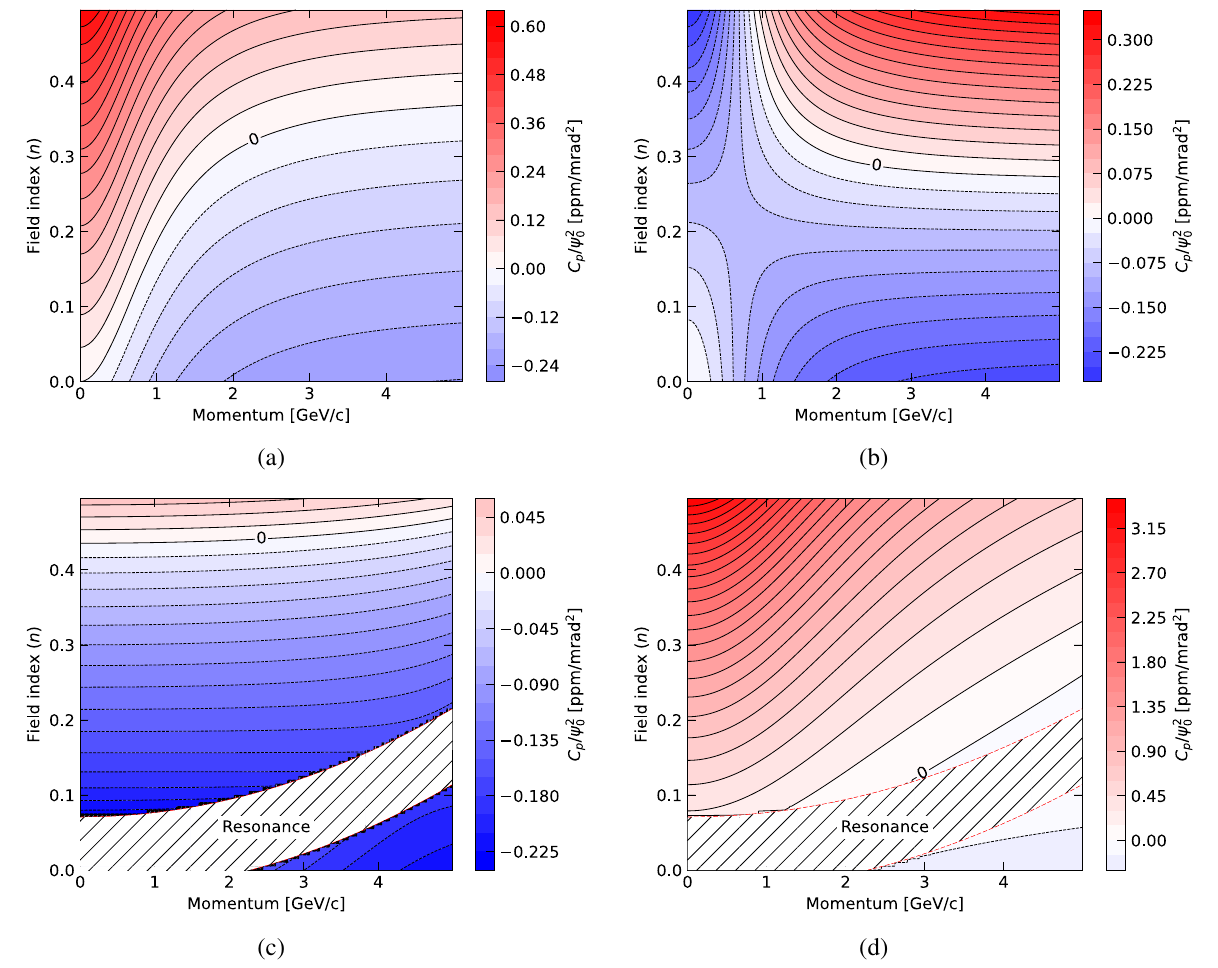
= ψ 2 0 ) in parts-per-million = mrad 2 as a function of the particle momentum and the FIG. 4. The pitch correction per square pitch angle ( C p weak focusing field index. Two particles, the proton with G ¼ 1 . 79 and the deuteron with G ¼ − 0 . 14 are plotted for both magnetic and electric focusing storage rings. Specific contour lines with the label 0 indicate when the pitch correction vanishes. For deuterons, the ω 2 hatched regions are near the spin resonance ω 2 and therefore are excluded in the plot. (a) For protons with magnetic focusing. a ¼ y (b) For protons with electric focusing. (c) For deuterons with magnetic focusing. (d) For deuterons with electric